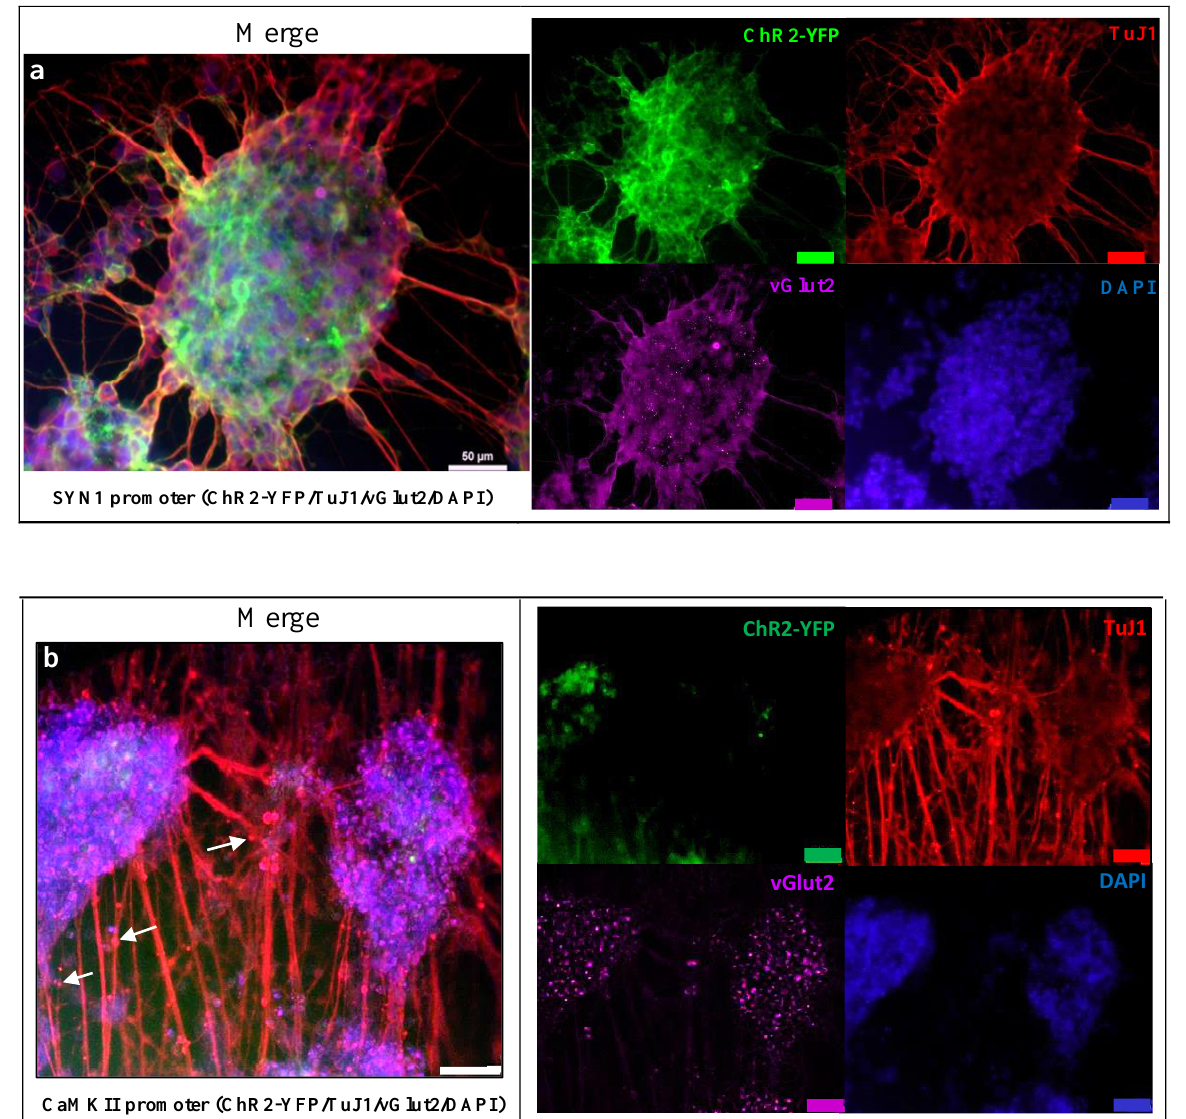
Figure 3. Immunofluorescent staining of neuronal differentiated human SH-SY5Y cells demonstrated positive expression of TuJ1 and vGlut2, containing ChR2-YFP under the control of ( a ) SYN1 promoter and ( b ) CaMKII promoter. The cells were cultured on a laminin-coated 24-well, glass-bottom plate in the complete medium after differentiation. The cells were then fixed, permeabilized, and stained with neural markers, TuJ1 (red) and vGlut2 (magenta) to identify the neuronal population. Opsin gene ChR2-YFP was expressed (labeled with green) whilst DAPI stained the nuclei blue. Functional vesicle transportation appeared as red dots along the neurites as shown in figure b (white arrows). Fluorescence images were obtained using confocal microscopy (Zeiss-LSM 780, Oberkochen, Germany) and processed with ZEN light software. Scale bar: 50 µm.